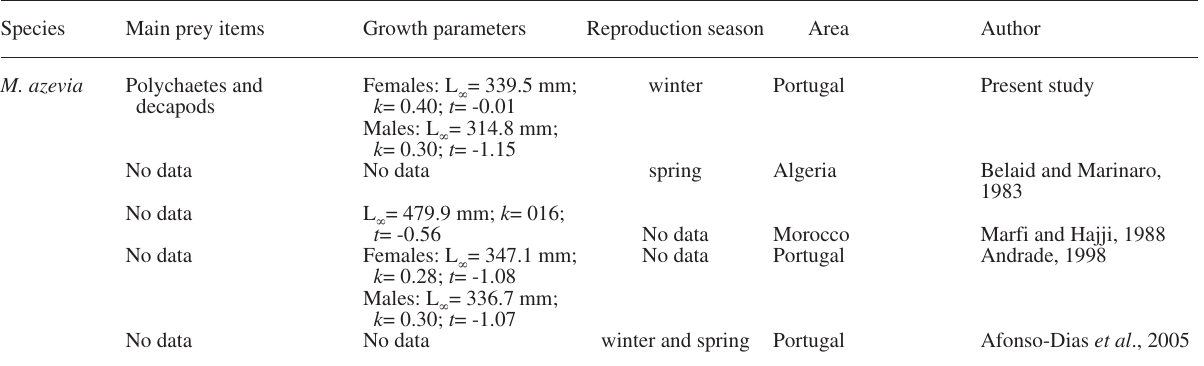
Table 3 (cont.). – Summary of main prey items, growth parameters and reproduction season for Citharus linguatula , Lepidorhombus boscii , Platichthys flesus and Microchirus azevia in different areas.